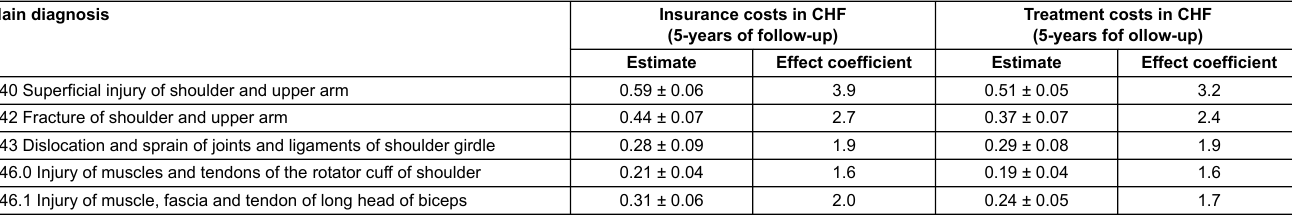
Table 4: Logistic regression estimate for the effect on the total insurance expenditures and on treatment costs, standardised for a 40-year-old male. Main